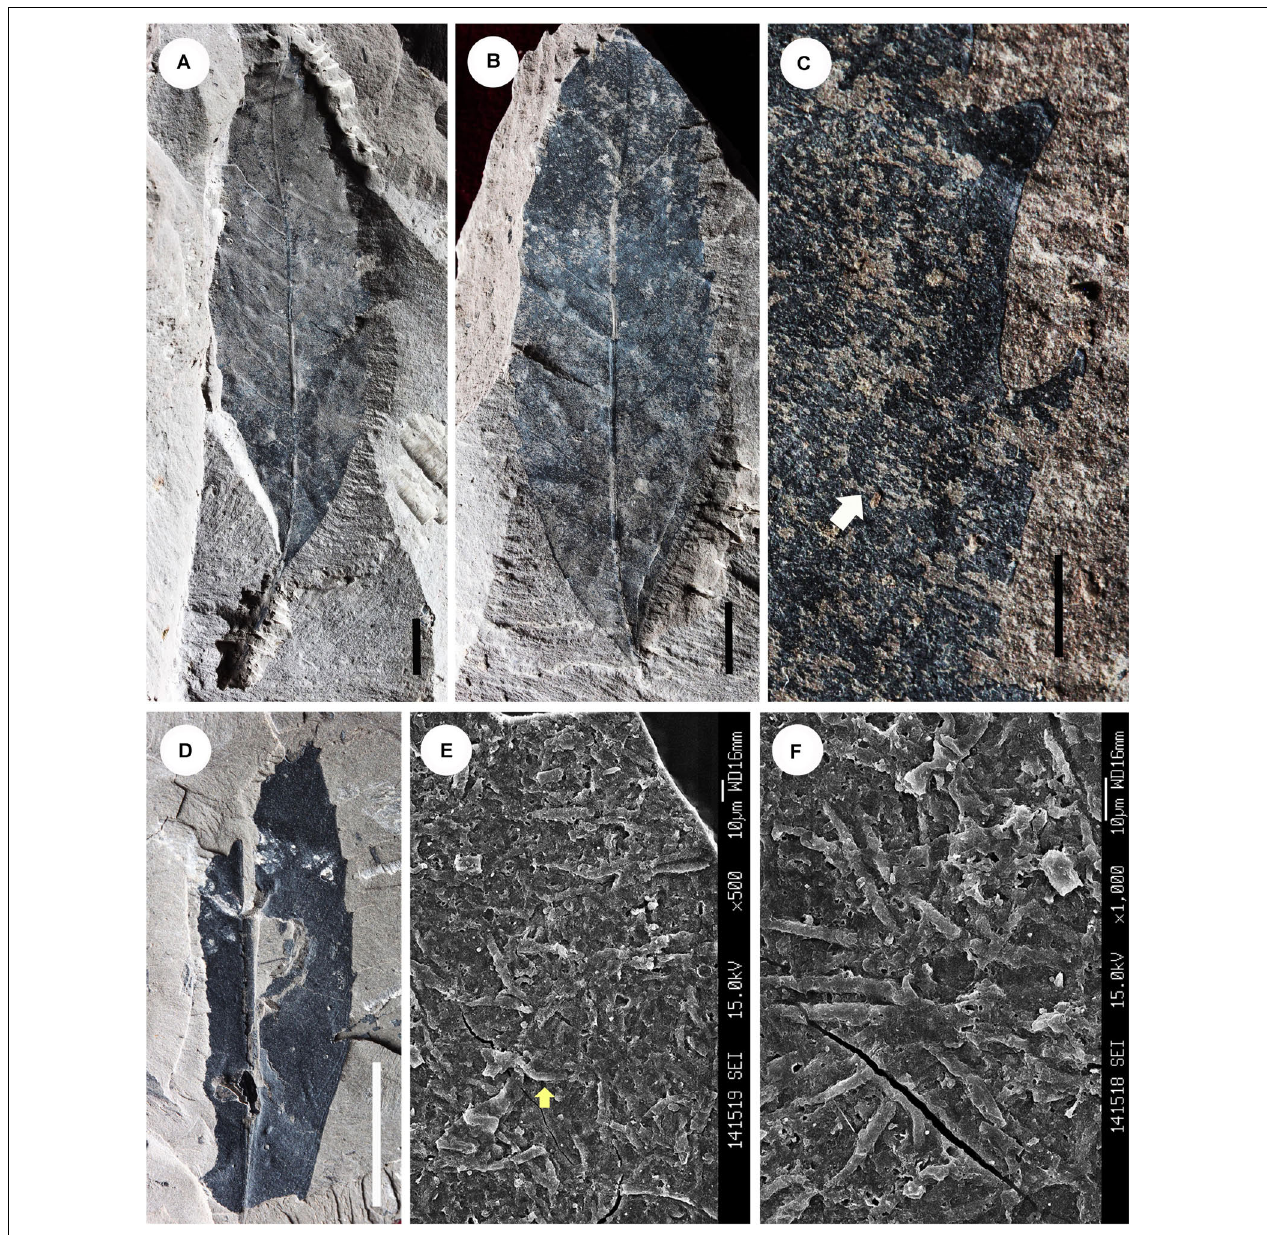
FIGURE 10 | Morphology of Quercus paleohypargyrea sp. nov. (A) Holotype. Specimen No. CC-1277a, showing the lanceolate leaf, more secondary vein; (B) counterpart of (A) , showing the median vein slightly bend; (C) Enlargement of (A) , showing the teeth and tertiary and quaternary veins (white arrow); (D) paratype Specimen No. CC-1108, showing the leaf morphology; (E) SEM image of (D) , showing the rugose outer surface and stellate trichomes (yellow arrow); (F) enlargement of E, showing the details of the stellate trichome. Scale bars: 10 mm (A,B,D) ; 2 mm (C)